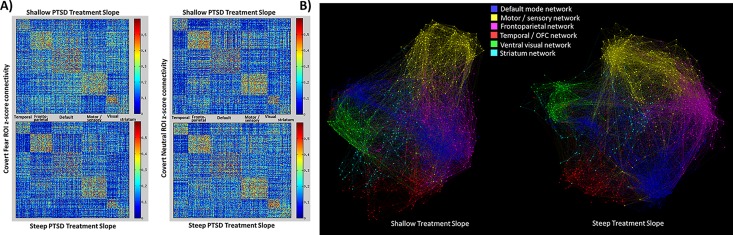
A) Heat map comparison of the median 824x824 functional connectivity matrices of participants with steep (n = 10) and shallow (n = 10) treatment slopes for pre-treatment covert fear blocks (left) and cover neutral blocks (right). B) Visual depiction of covert fear network organization (from the left hand column in Panel A) for the participants with steep (n = 10) and shallow (n = 10) treatment slopes. The figures were generated using Gephi (v0.8.2) with the ForceAtlas2 graph layout algorithm using group-level connectivity matrices with a density threshold of 0.02.